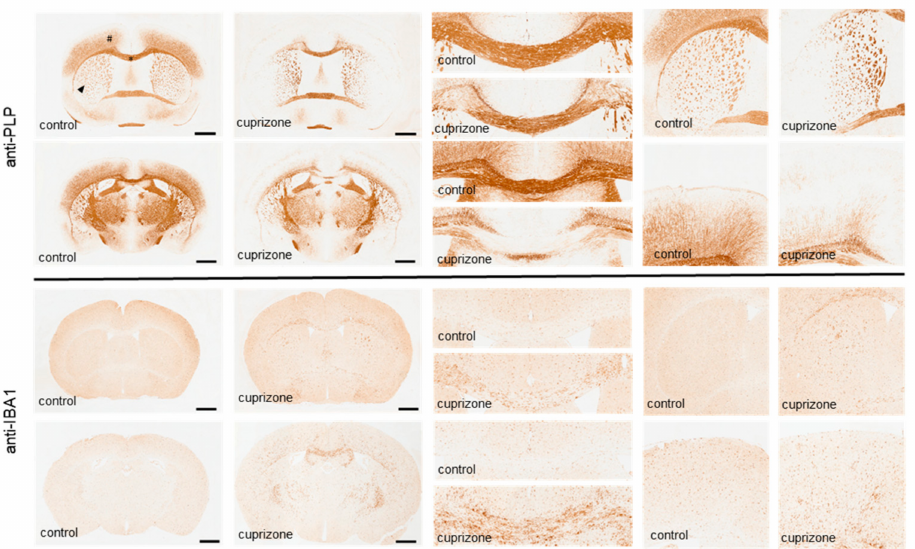
Figure 2. Representative images of anti-PLP and anti-IBA1 stained sections from control and 5 weeks cuprizone-intoxicated mice to demonstrate demyelination and the concomitant activation of microglia. * = midline of the corpus callosum; # = motor cortex; arrowhead = caudoputamen, Scale bar: 1 mm. Adopted from